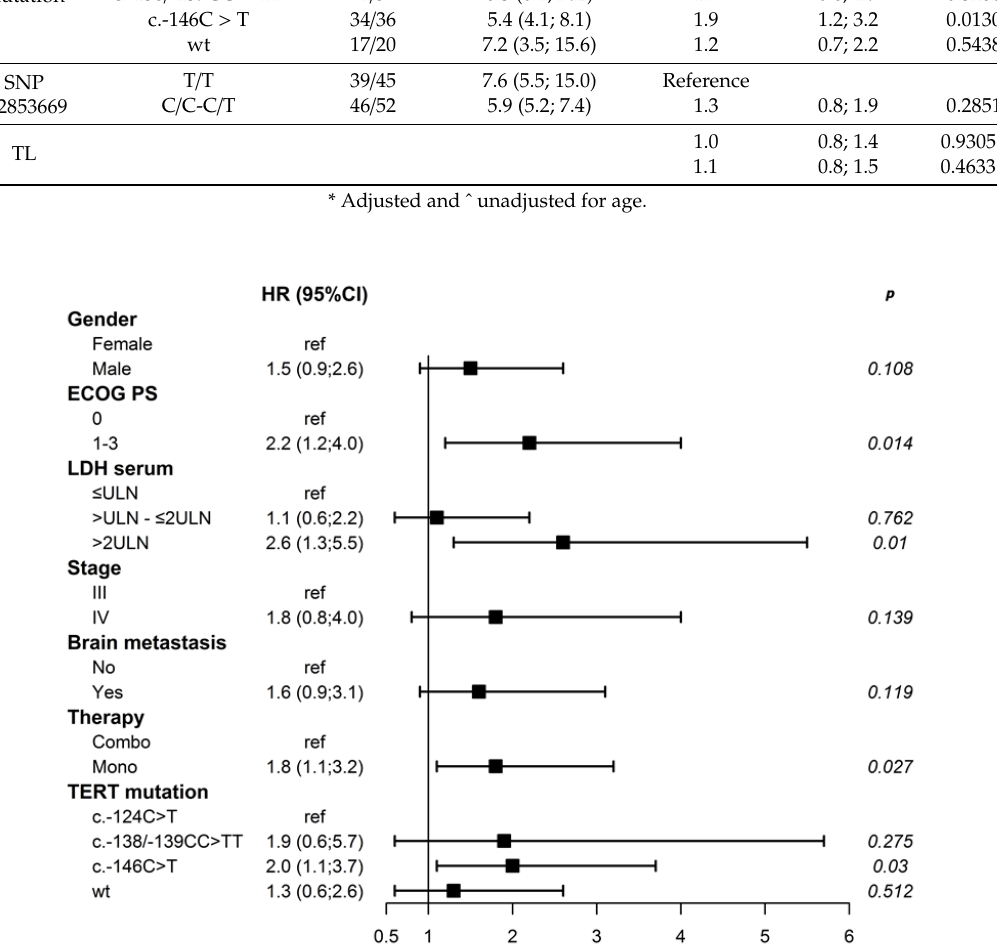
Figure 1. Forest plot showing hazard ratios for progression-free survival using a multivariable Cox proportional hazards model.